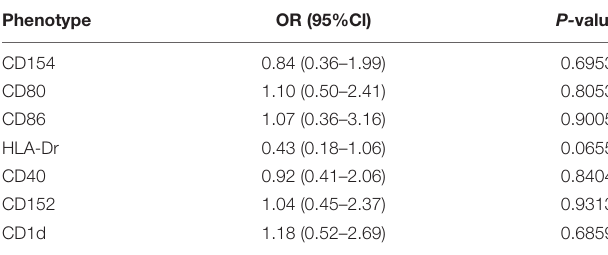
TABLE 3 | Effects of MedDiet on the expression of co-stimulatory